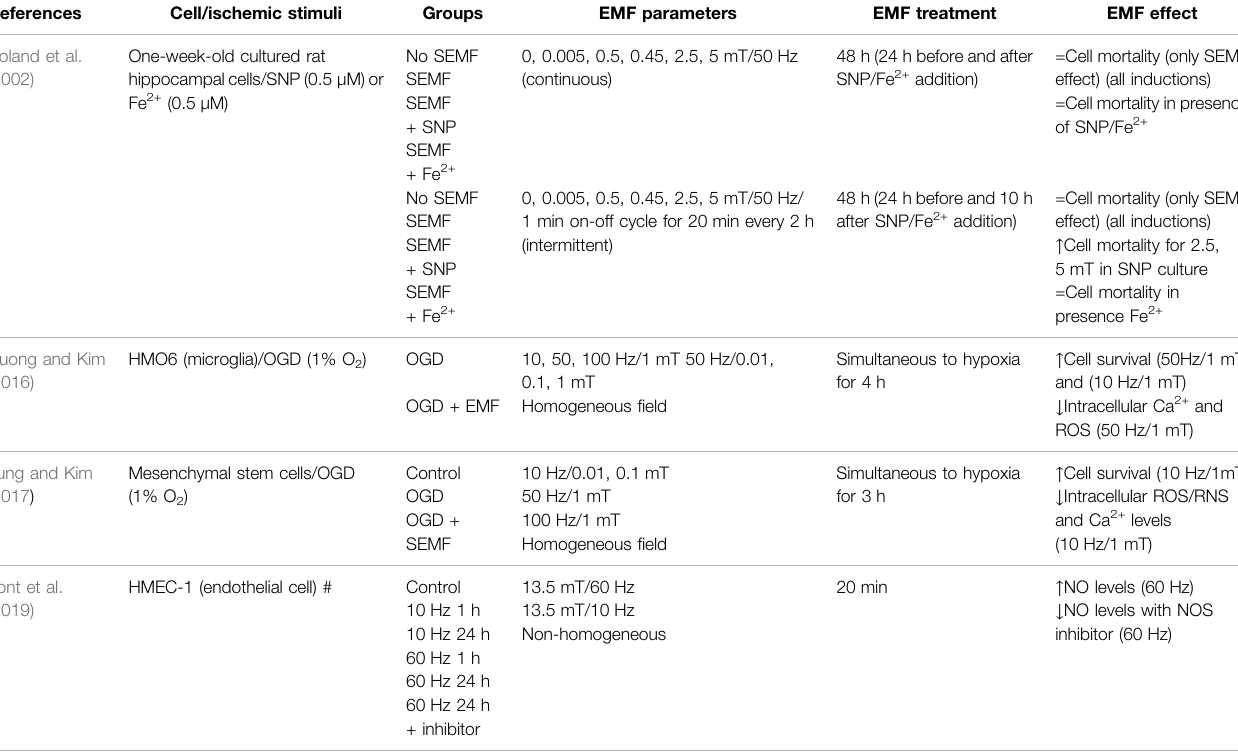
SEMF:sinusoidalelectromagnetic fi elds;SNP:sodiumnitroprusside;OGD:oxygenglucosedeprivation;ROS:reactiveoxygenspecies;RNS:reactivenitrogenspecies;HMEC-1:human immortalized microvascular endothelial cells; NOS: nitric oxide synthase. This in vitro study was considered because the author also performed stroke in vivo experiments with